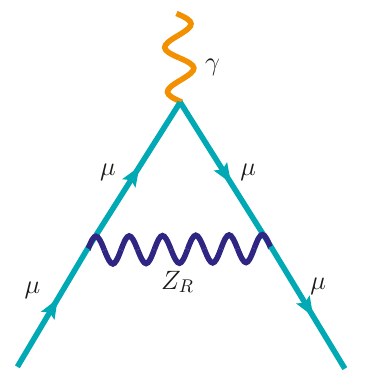
2 contribution arising from the mediation of (cid:0)